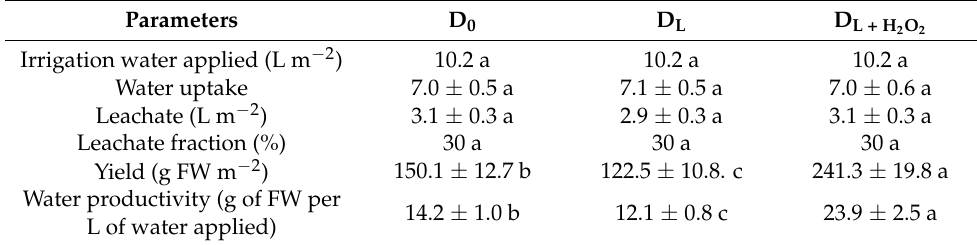
—raw leachate 2 2 O 2